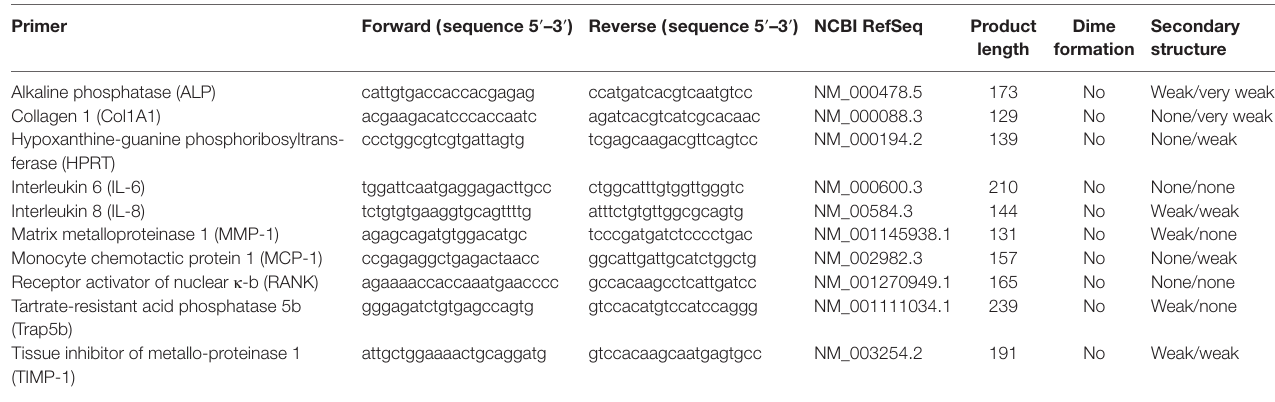
TaBle 1 | cDNA target sequences for qRT PCR.